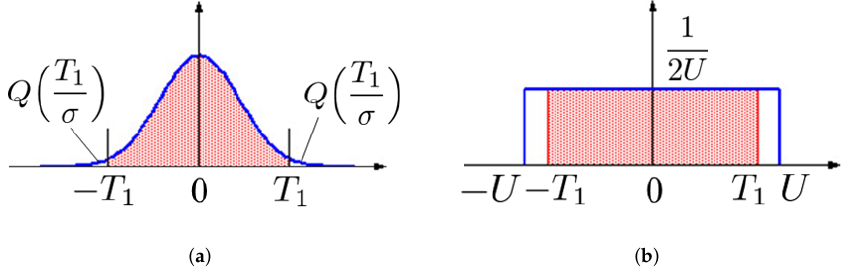
Figure 4. Example of probability distribution function of initial weight values ( a ) Gaussian ( b )